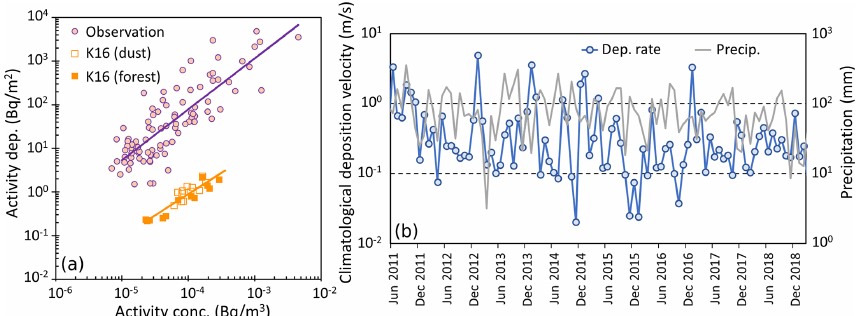
Figure 9. (a) Scatterplot of (purple circles) observed airborne surface concentrations and deposition of 137 Cs as well as those simulated (by Kajino et al., 2016; K16) considering different emission sources, mineral dust from bare soil (orange open squares) and aerosols emitted from forest ecosystems (orange solid squares). The purple and orange lines indicate the regression lines of the observed data and the simulated (both dust and forest) data, respectively. (b) Time series of (blue) climatological deposition velocity on the left axis and (gray) precipitation amounts on the right axis.